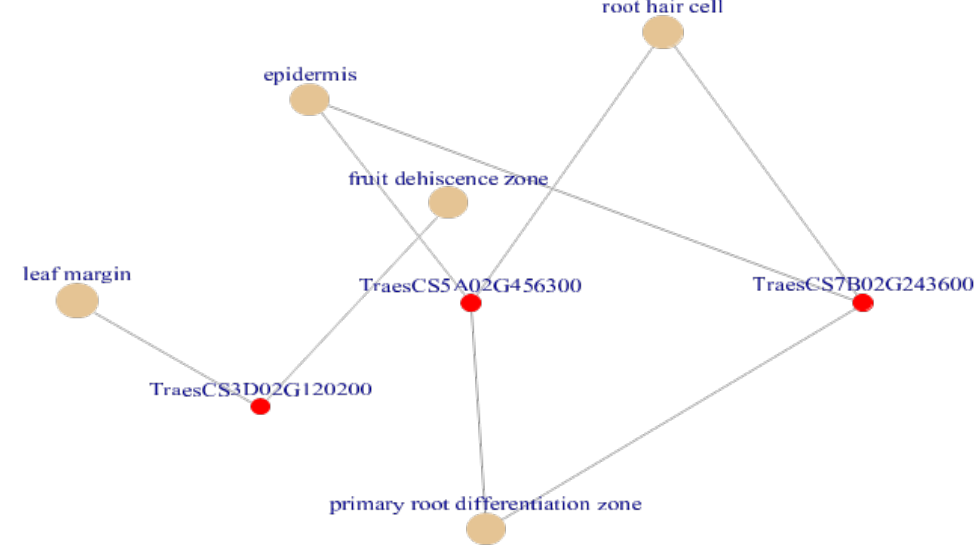
Figure 7. Cnetplot created using plant ontology enriched terms (Adjusted p < 0.05). Out of all enriched terms epidermis, root hair cell, lead margin, fruit dehiscence zone and primary root differentiation zone terms are plotted by default which was associated with drought in wheat. The terms primary root differentiation zone, epidermis and root hair are governed by the DE genes are TraesCS5A02G456300 and TraesCS7B02G243600.